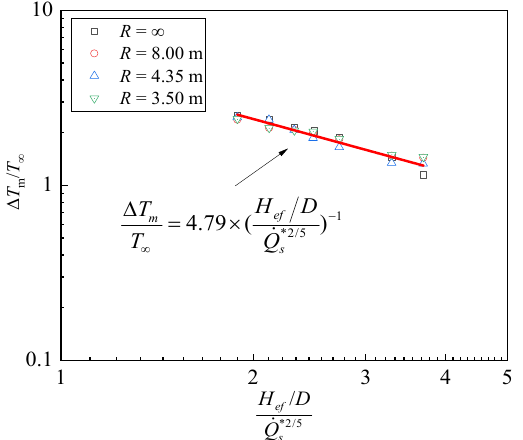
Figure 6. Predicted correlation of maximum temperature for the scenario of strong plume-driven ceiling jet.